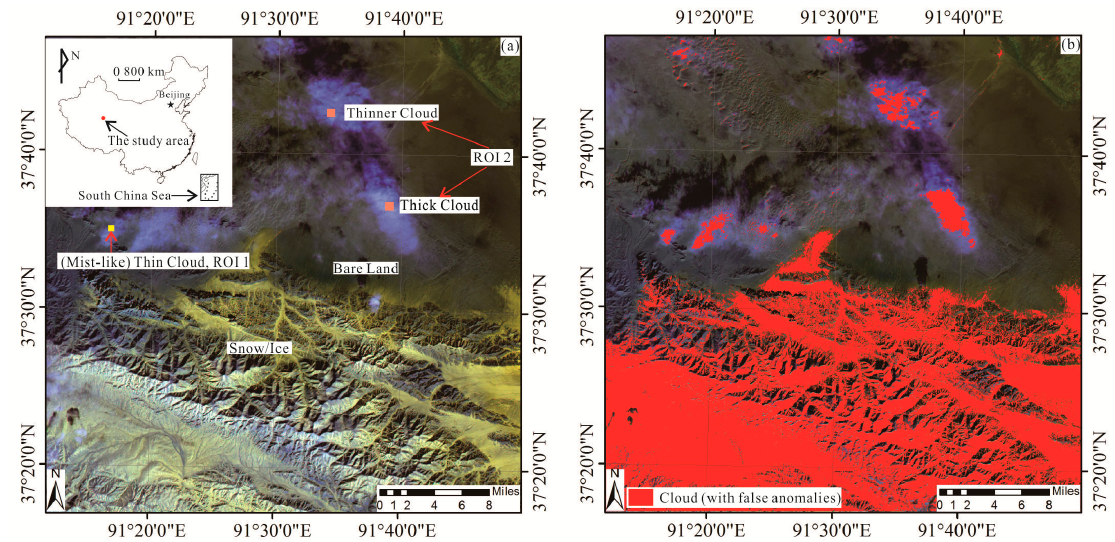
Figure 2. High resolution Sentinel-2 images of the study area (cropping the region of interest, false color composite to help the reader visually differentiate between snow/ice and clouds [32]. Bands 4, 10, and 11 for Red, Green, and Blue, respectively), with the ( a ) original image, ( b ) cloud detection results using the traditional maximum-likelihood method.